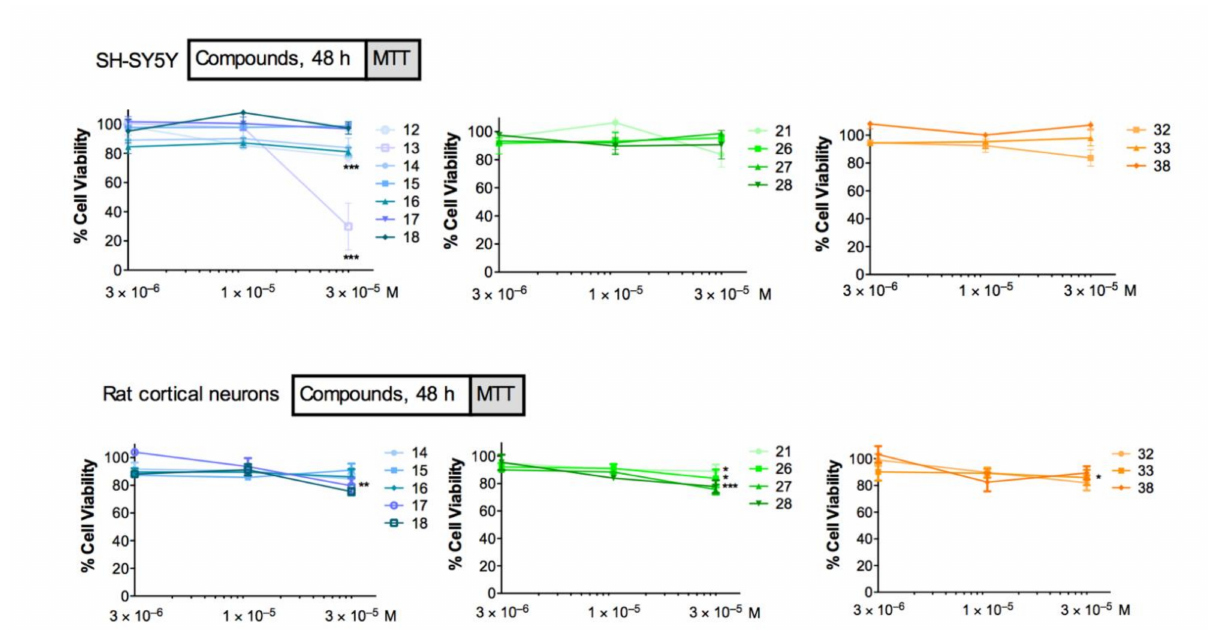
Figure 2. Effect of compounds on the cell viability of SH-SY5Y cells and rat cortical neurons, measured by the MTT method. Data are means ± SEM of at least three independent experiments, normalized over the maximum cell viability (basal = 100%), obtained from SH-SY5Y cells or rat cortical neurons not exposed to any compound.*** p < 0.001, ** p < 0.01, * p < 0.05, compared with basal